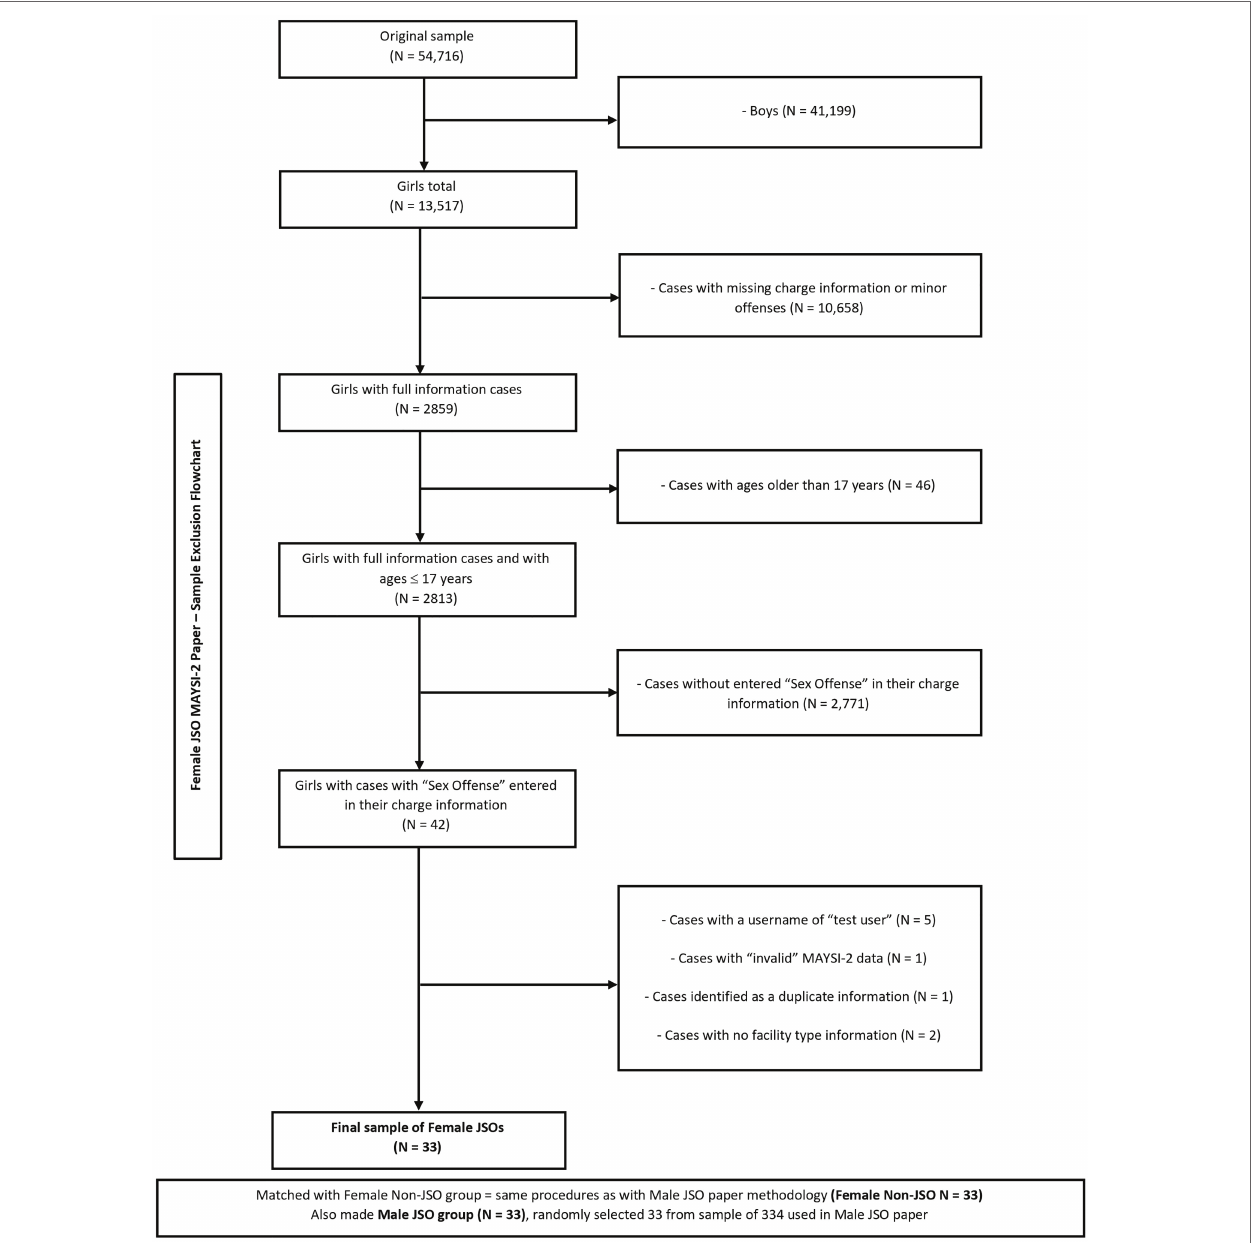
FIGURE 1 | Flowchart illustrating how the final sample was selected and the number of cases resulting after each step of applying the exclusion